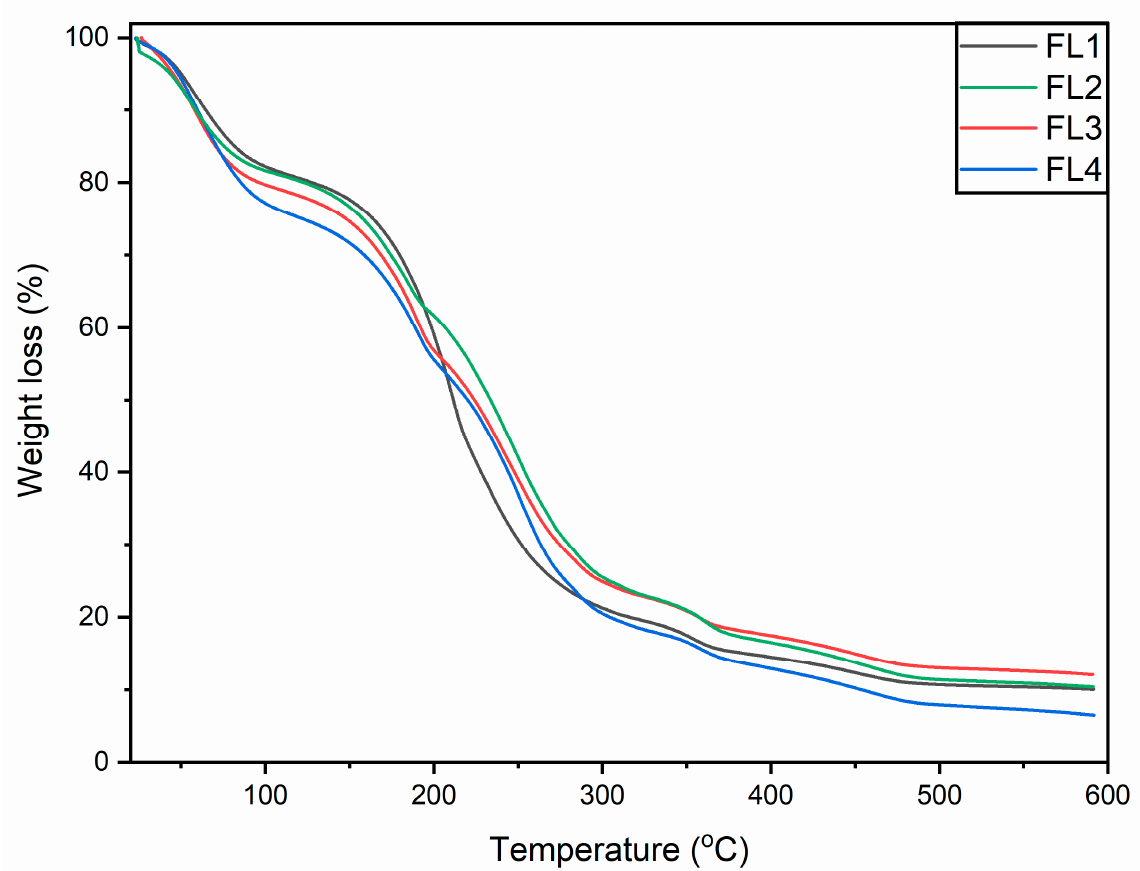
Figure 4. TGA thermograms of FL1–FL4 composite films samples: control or FL1 (CA + SA); FL2: CA + SA + OEO (1.5% v/v); FL3: CA + SA + OEO (2 % v/v); FL4: CA + SA + OEO (2.5% v/v).